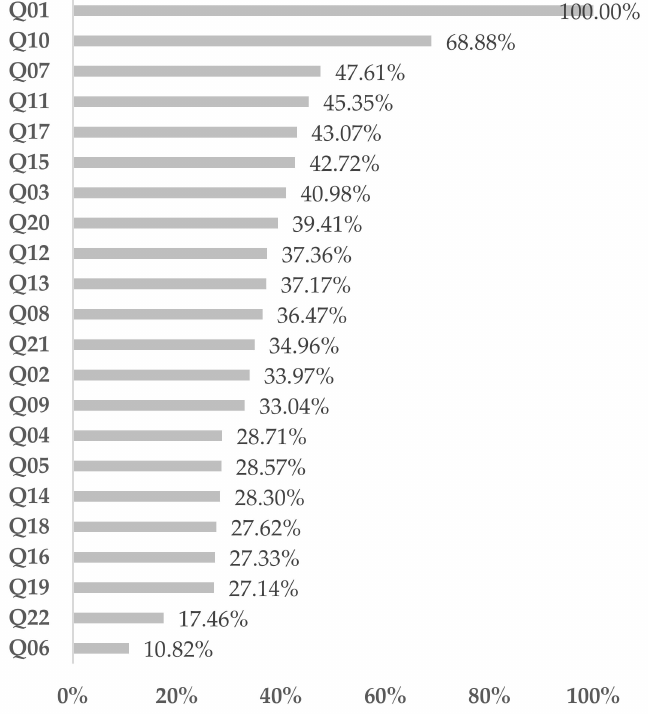
Figure 2. Relevance of exogenous variables in the ANN